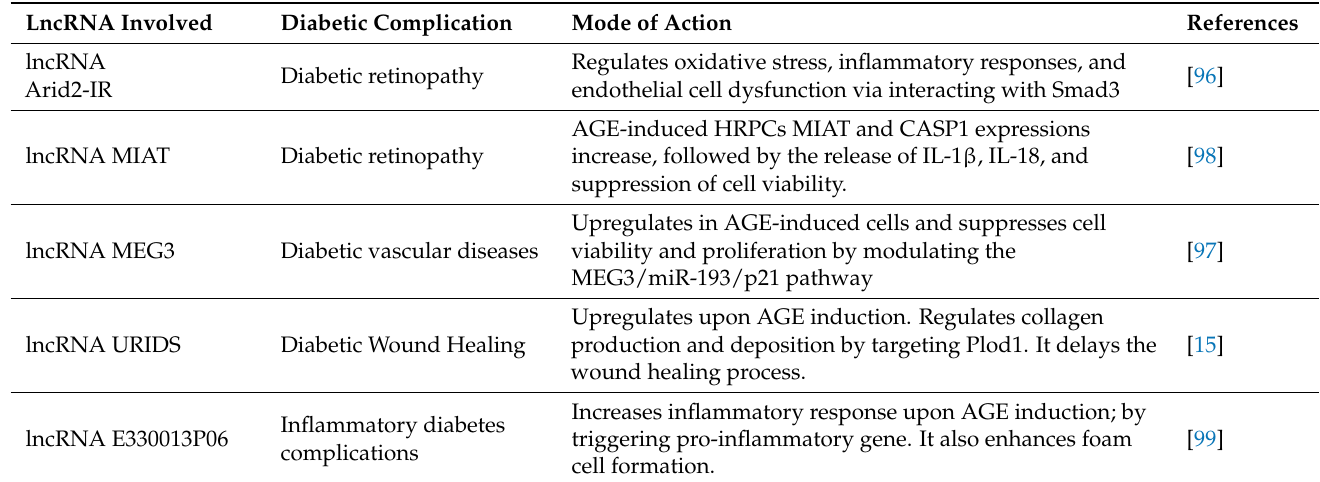
Table 2. LncRNAs involved in glycation/AGE-associated diabetic